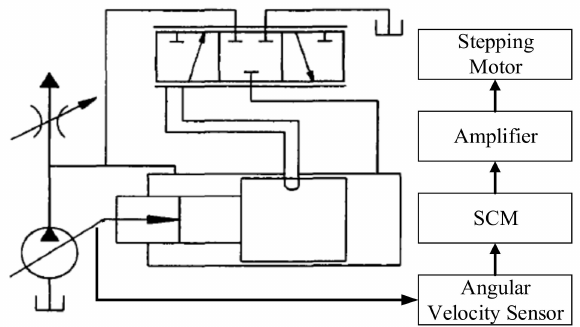
Figure 10. Digital hydraulic pump controlled by the stepping motor.